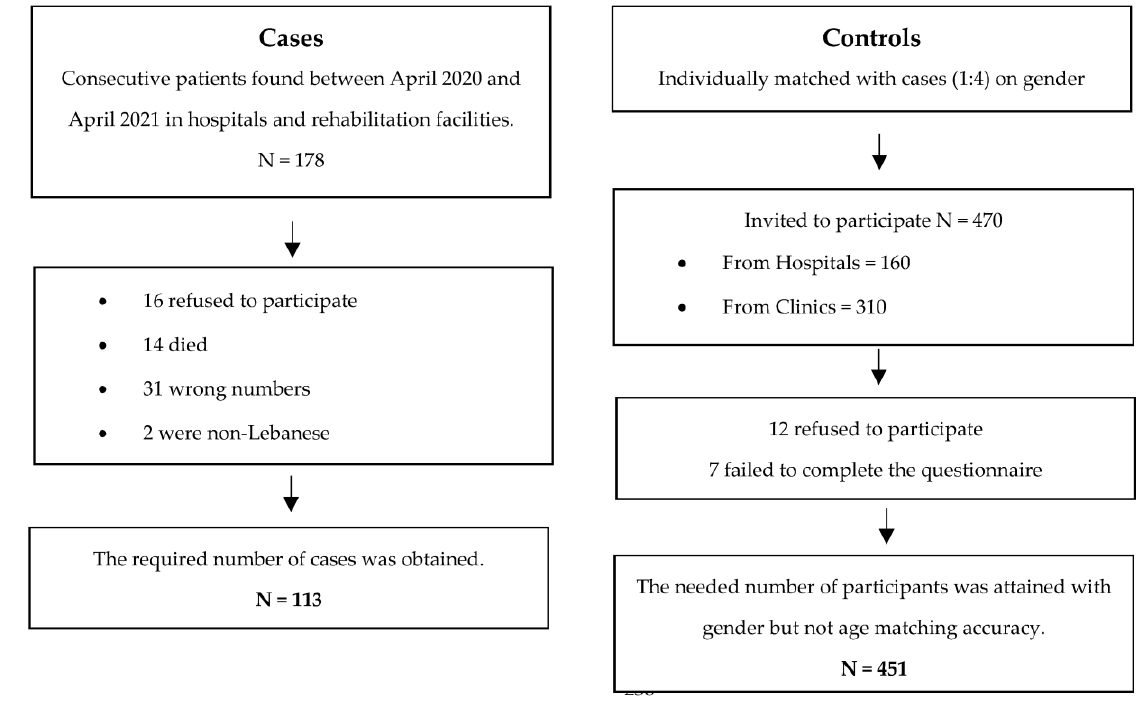
Figure 1. Participants’ flowchart.